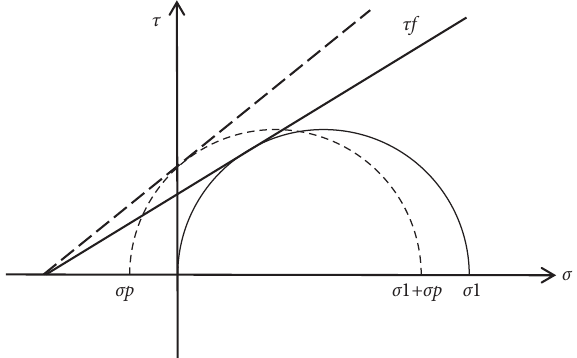
Figure 6: Te relationship between the Mohr circle and shear strength